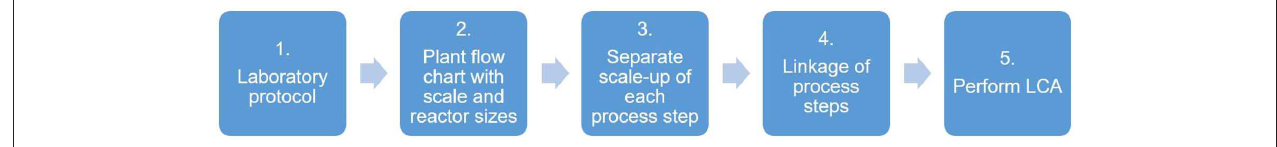
FIGURE 1 | Up-scaling framework steps proposed in Piccinno et al. (2016).